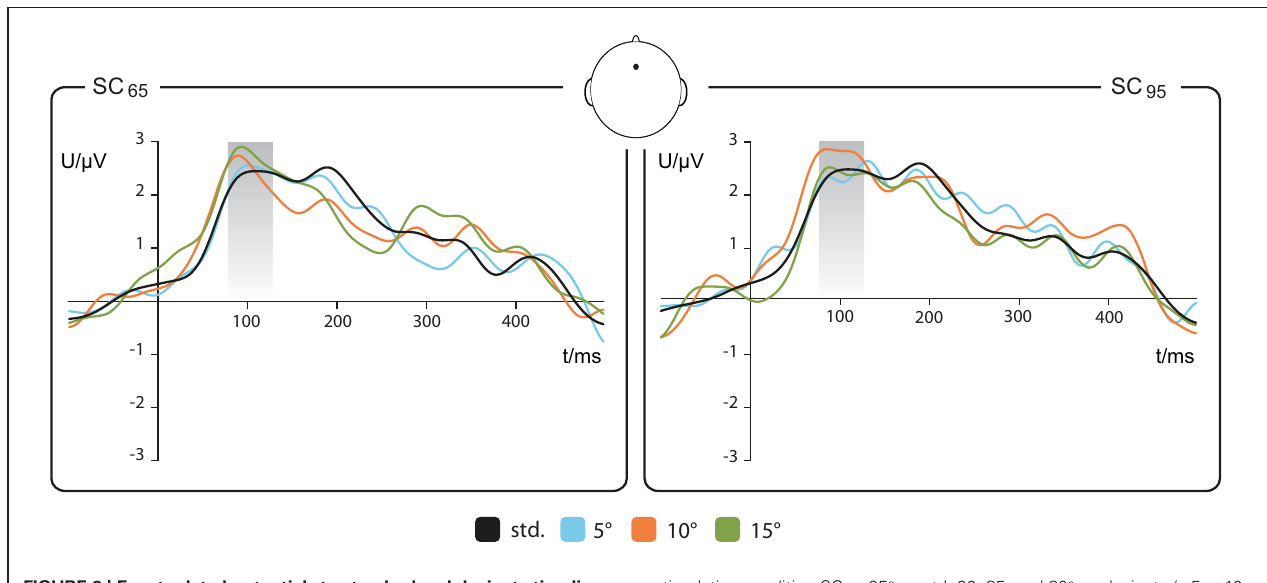
FIGURE 2 | Event-related potentials to standard and deviant stimuli. Grand averaged EEG epochs recorded at Fz, see sketch of the view from above to the head. Left : stimulation condition SC 65 , 65 ◦ as standard (std), 70, 75, and 80 ◦ as deviants ( − 5, − 10, and − 15 ◦ deviation relative to std). Right :